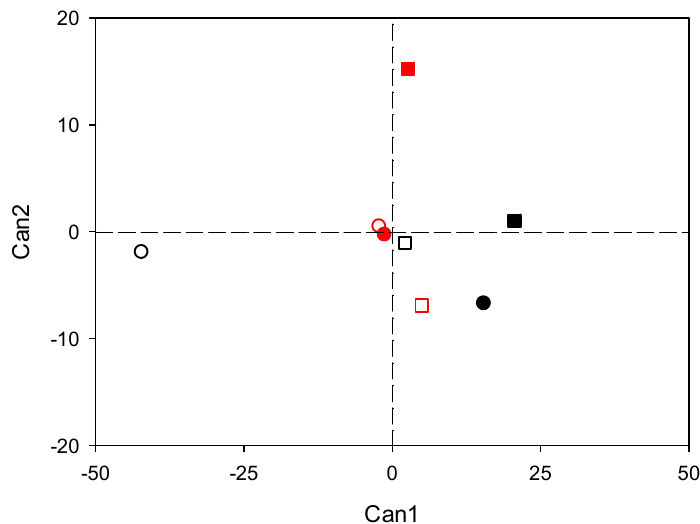
Figure 8. Discrimination between cultivar (Emilio Lepido, black; Svevo, red), waterlogging treatment (control, open; waterlogged, closed), and waterlogging duration (14 days, circle; 35 days, square) on the basis of canonical discriminant analysis applied to the full set of parameters collected at the end of waterlogging treatments. The first two canonicals are shown (Can1 and Can2).